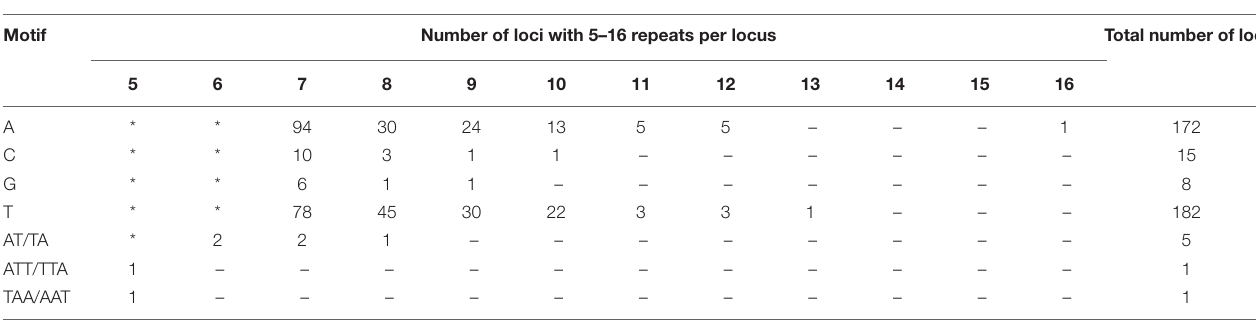
FIGURE 1 | Distribution of nucleotide (A, T, C, and G), GC- and AT-rich content in the plastome of curly birch (plus strand). TABLE 1 | Microsatellite loci in the curly birch